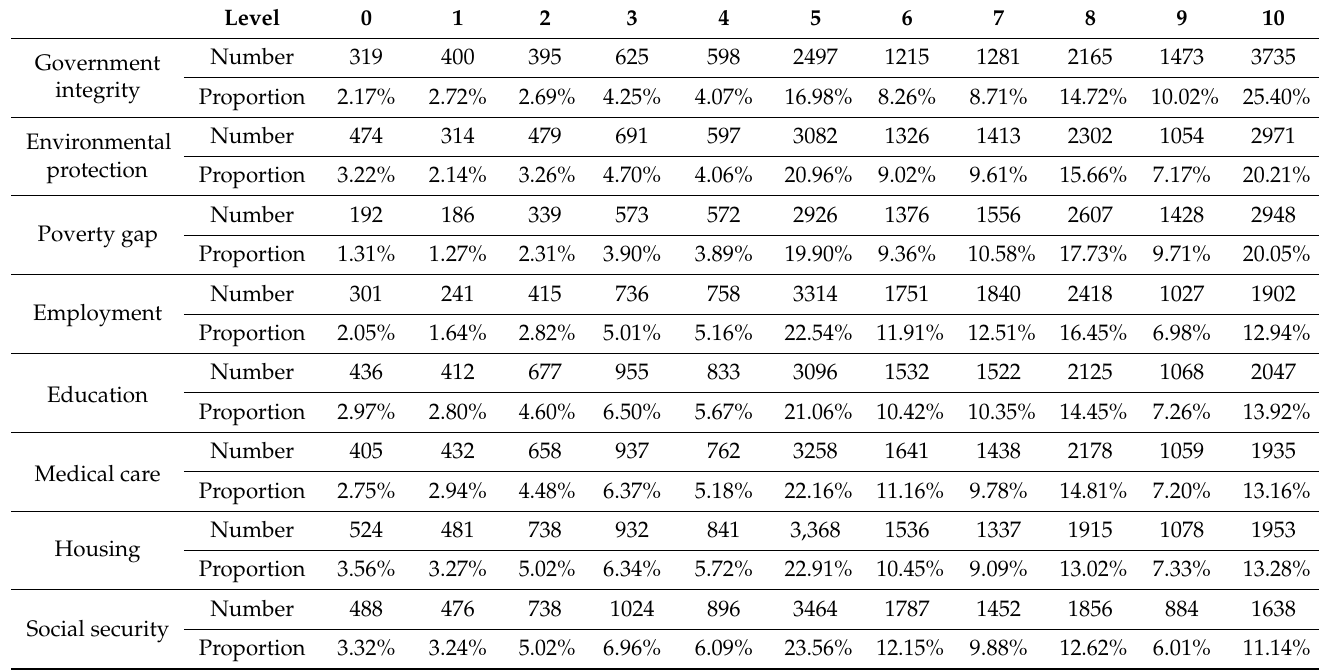
Table 3. Scores of rural residents’ satisfaction with the social environment.